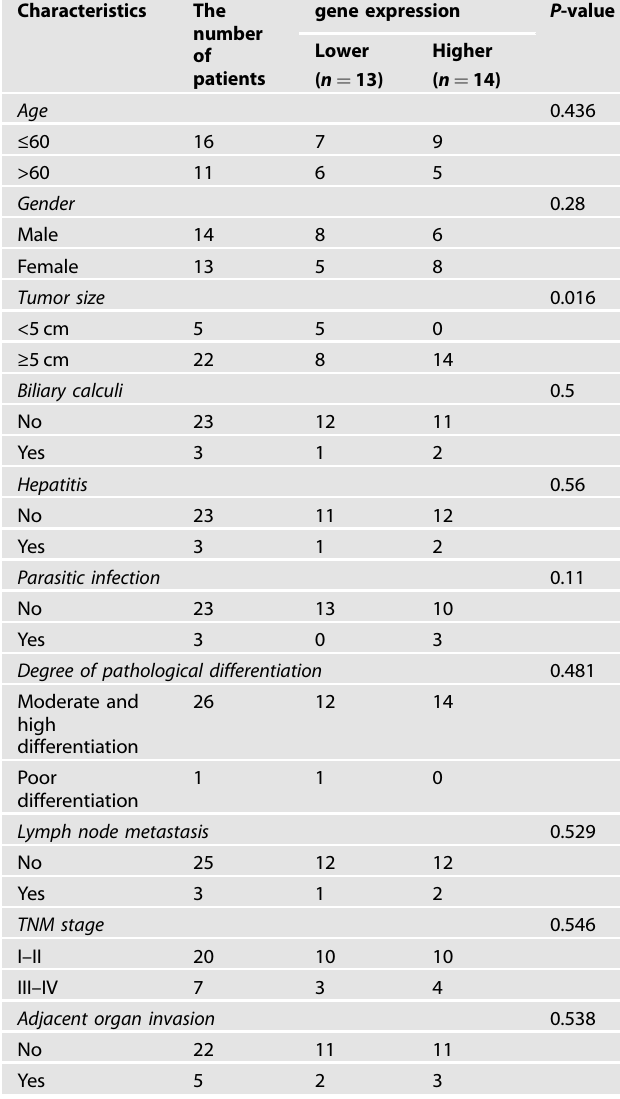
Table 1. Correlation between circMBOAT2 expression and clinical features in